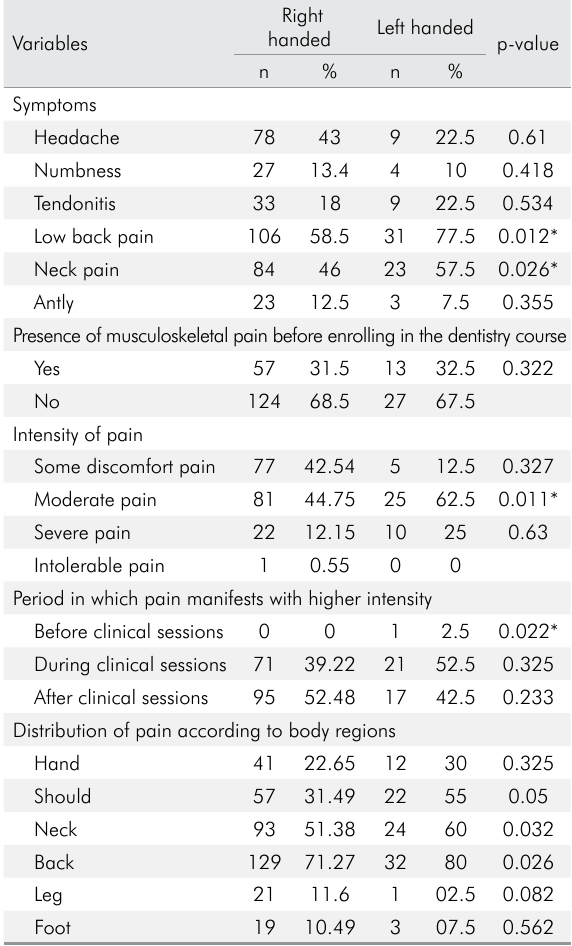
Table 3. Distribution of pain and the symptoms reported by right- and left-handed students.